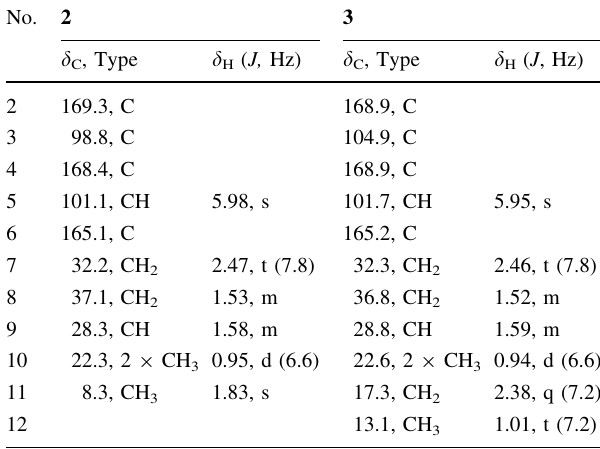
Table 1 1 H (600 MHz) and 13 C NMR (150 MHz) data of 2 and 3